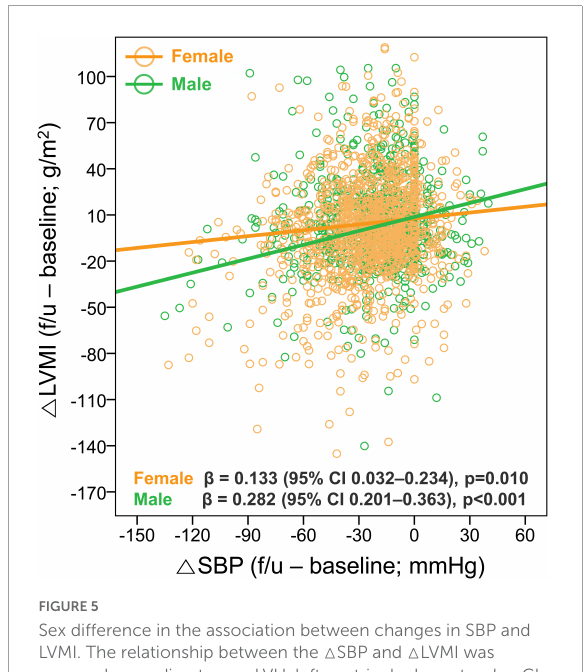
FIGURE5 Sex difference in the association between changes in SBP and LVMI. The relationship between the (cid:77) SBP and (cid:77) LVMI was assessed according to sex. LVH, left ventricular hypertrophy; CI, confidence interval; SBP, systolic blood pressure; LVMI, left ventricular mass